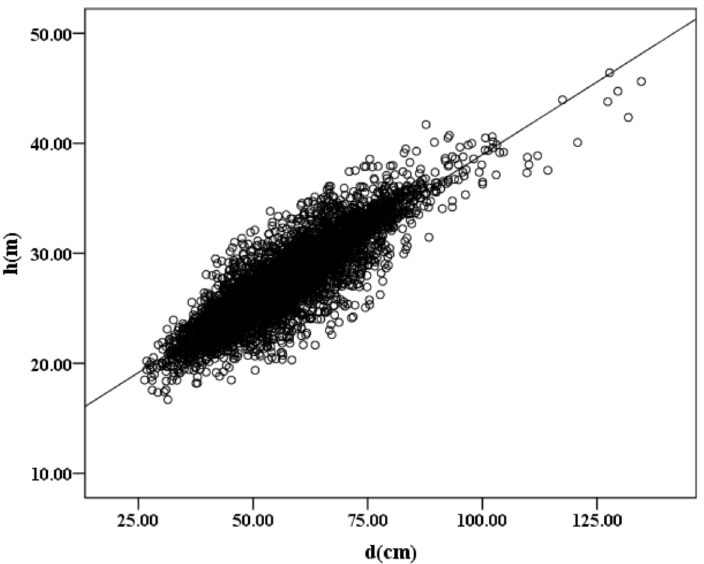
Fig 2. Scatter diagram of the tree height and dbh of a single Metasequoia tree. doi: 10.6084/m9. figshare.4956284.g002.